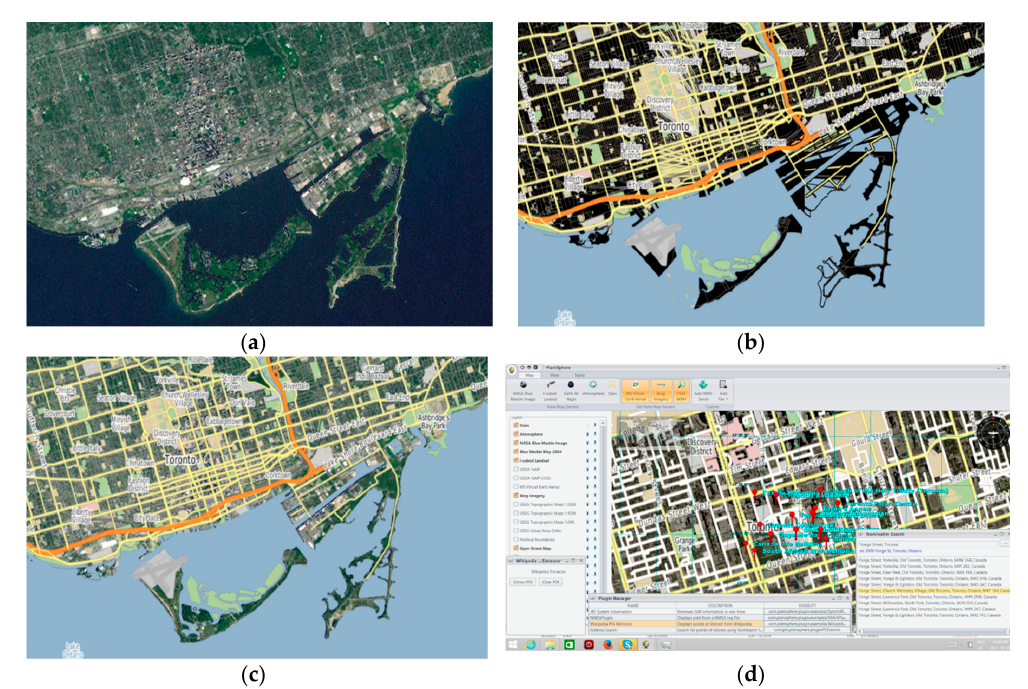
Figure 4. Fusion of multiple layers from different WMS servers: ( a ) LandSat7 photograph of Toronto, ( b ) OpenStreetMap roadmap, ( c ) OpenStreetMap map superimposed over a LandSat photograph, and ( d ) After analyzing using